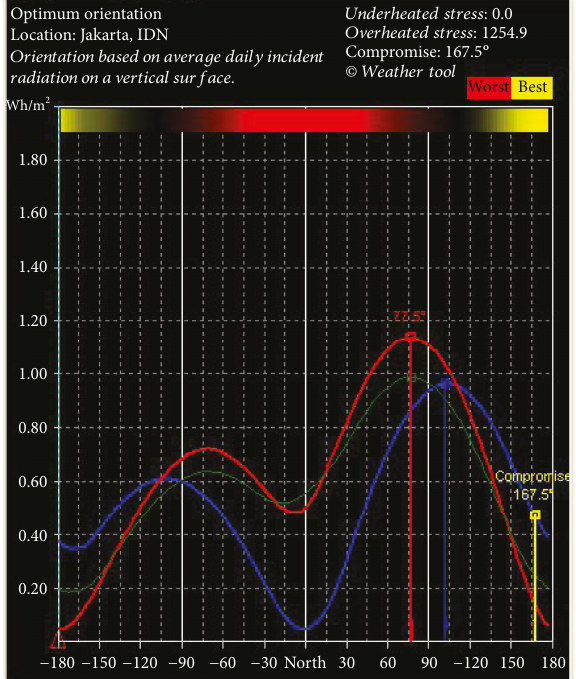
Figure 2: The direction of most sunlight throughout the year.